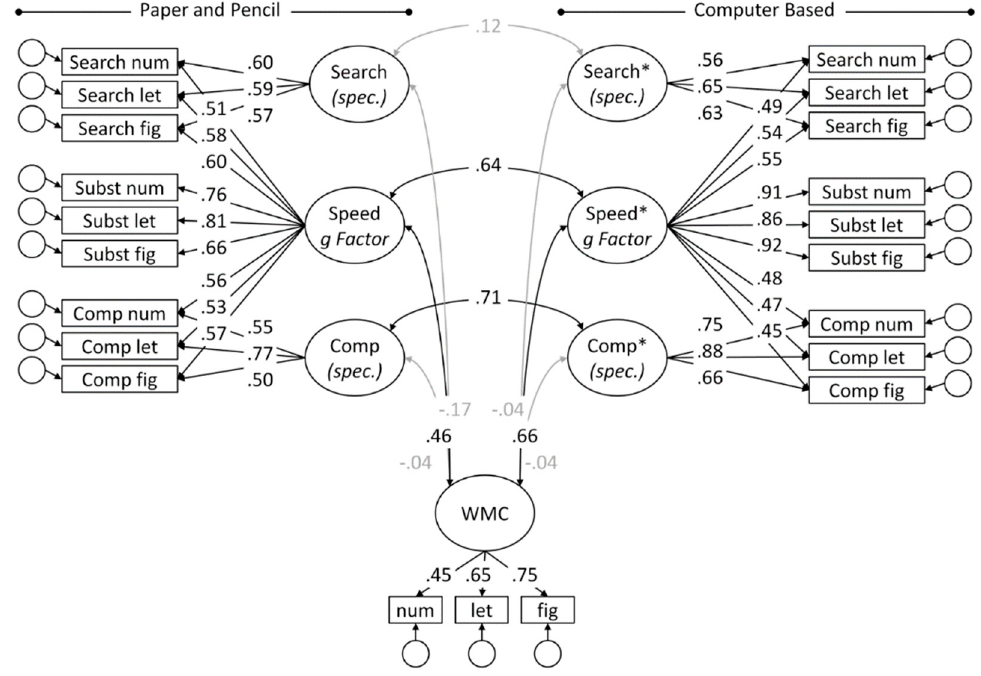
Figure 3. Relations of bifactor models fitted to PP and CB speed task across mode of administration, and with WMC, jointly for Search, Comparison, and Substitution tasks (Model 2).